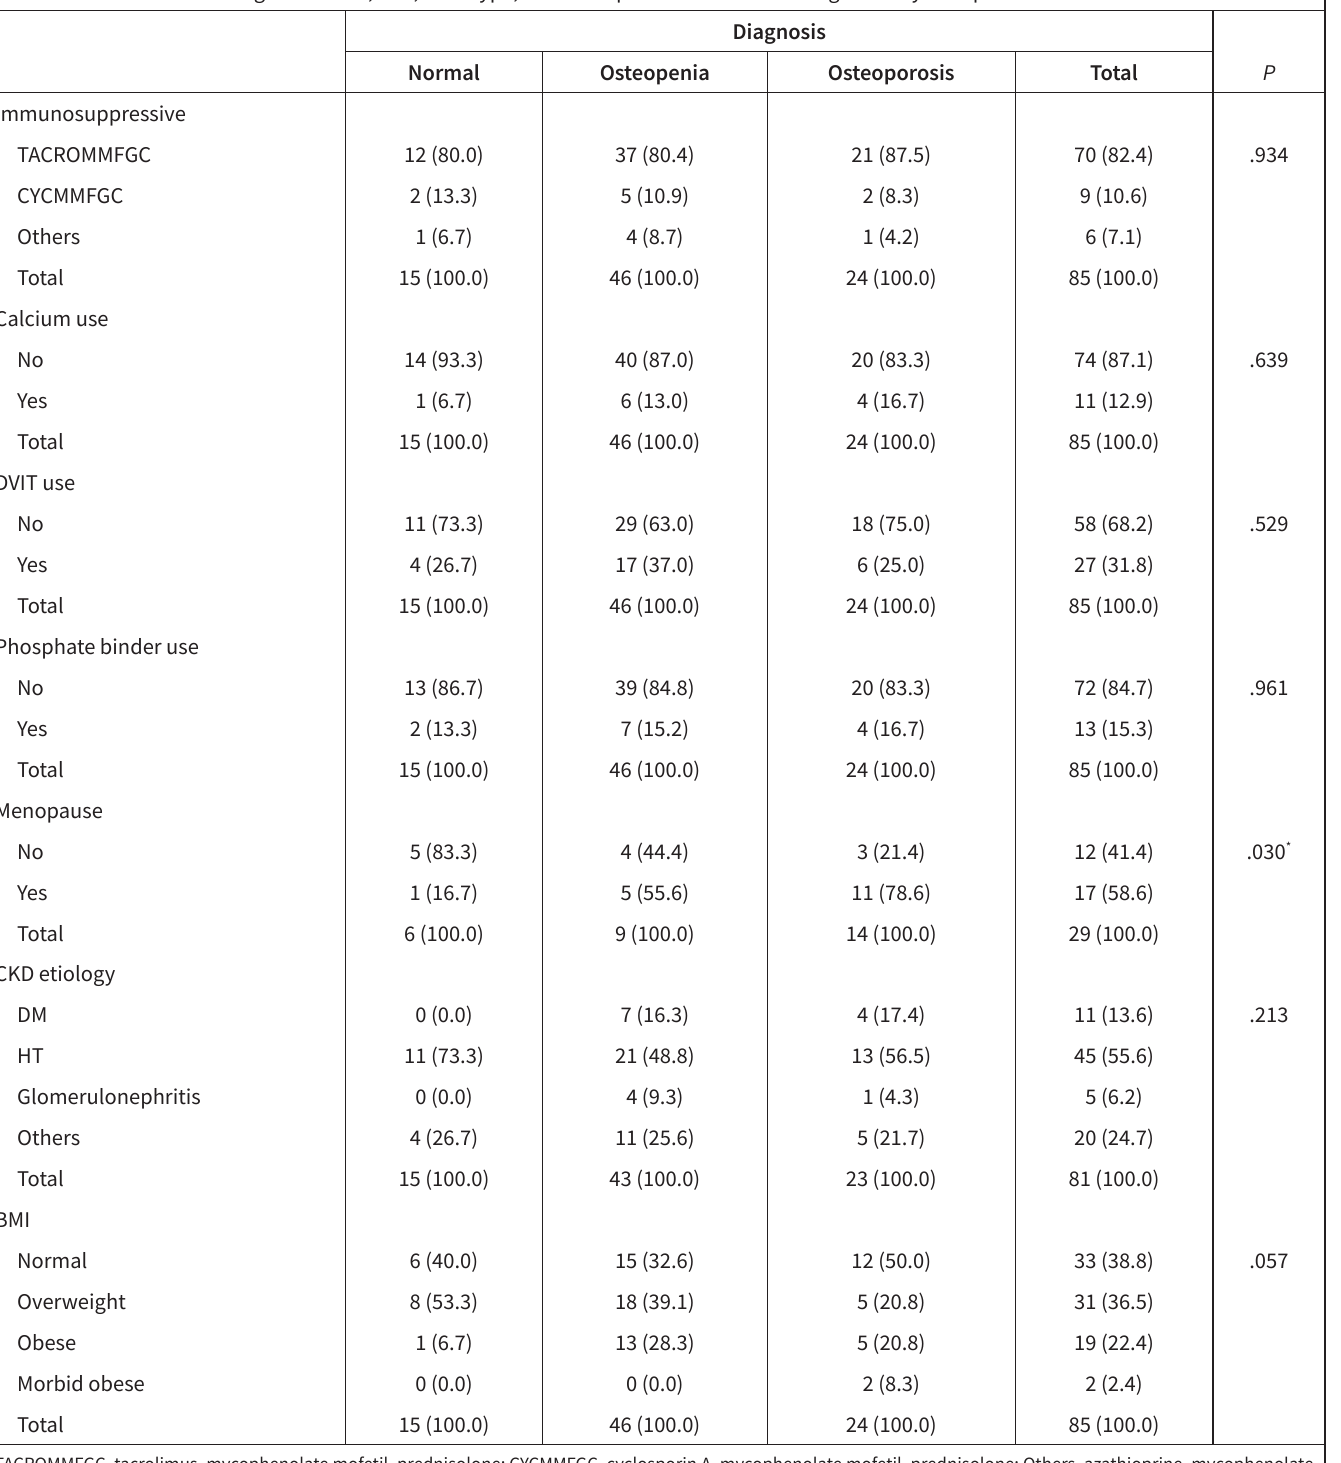
Table 3. Distribution of Drug Use Status, BMI, CKD Type, and Menopausal Status According to Study Groups